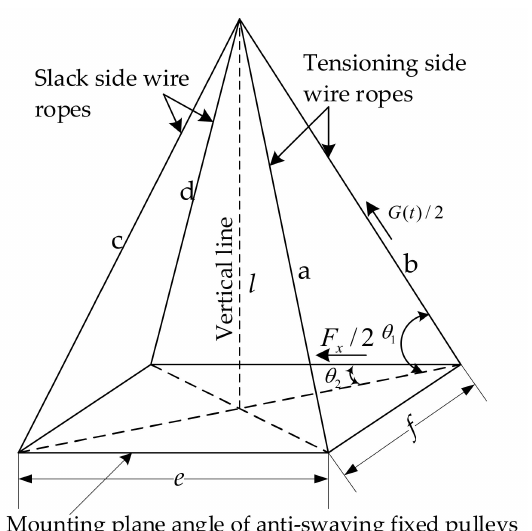
Figure 4. Schematic diagram of the spatial layout of the anti-swaying wire